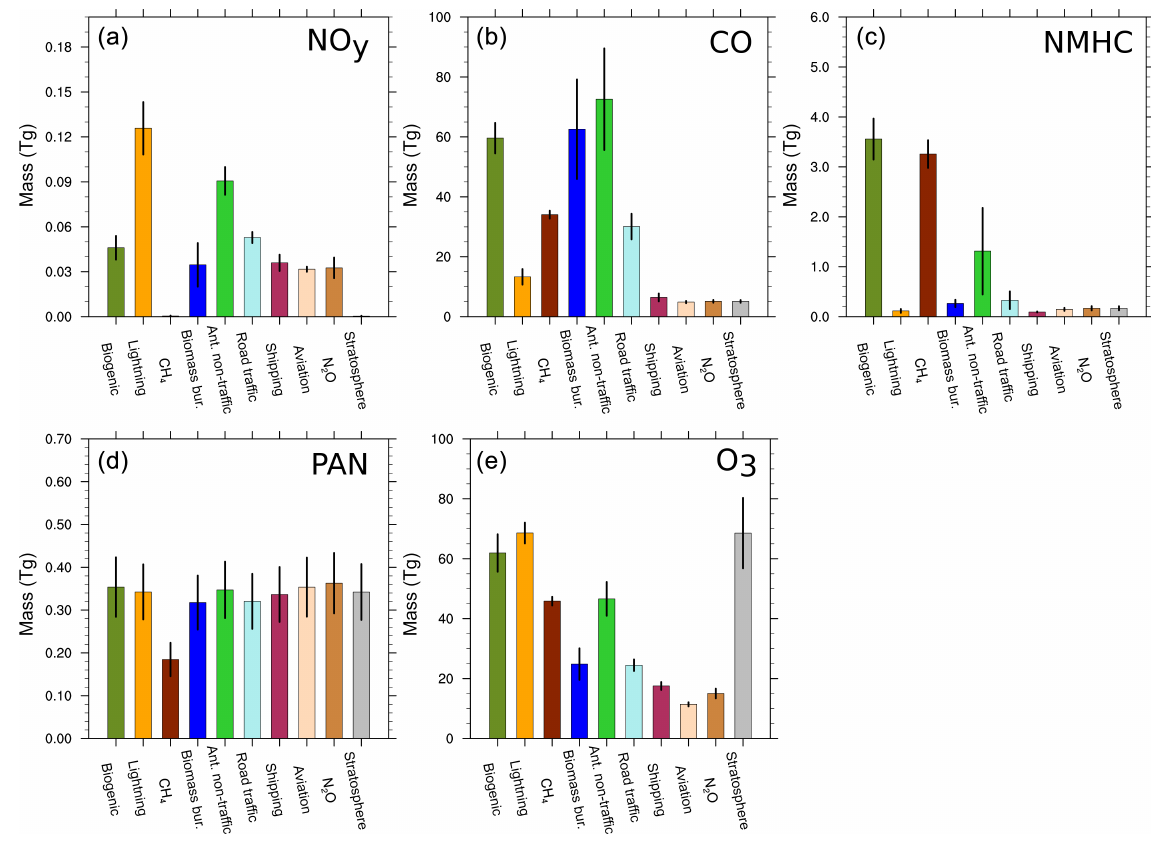
Figure 5. Contributions to the annual mean tropospheric budgets [Tg] of 10 emission sectors. (a–c) NO y , CO, and NMHCs; (d, e) PAN and O 3 . Error bars indicate the interannual variability. Table 5. Qualitative characterisation of four different regions (A–D) in the Mediterranean Sea. A: southern France; B: Strait of Gibraltar; C: central Mediterranean Sea; D: Tunesian coast. See Fig. 6 (top row) for the location of the regions. The signs “ ++ ”, “ + ”, “ ◦ ”, and “ − ” indicate a qualitative estimate of the respective characteristics, “very strong/very large”, “strong/large”, “moderate”, “negative”.